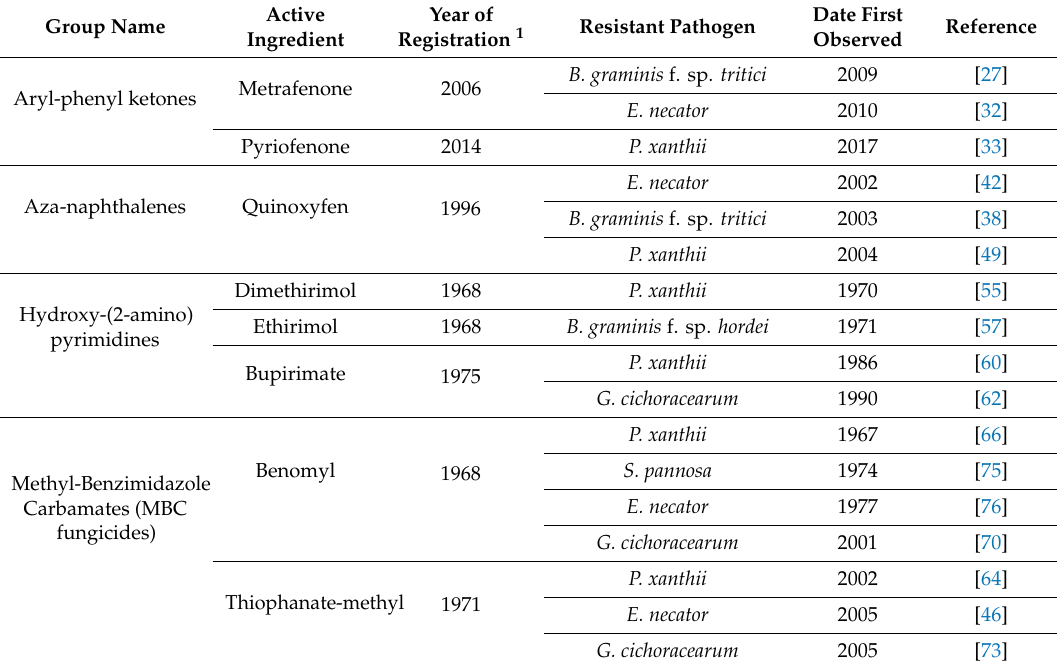
Table 2. Occurrence of field fungicide resistance in powdery